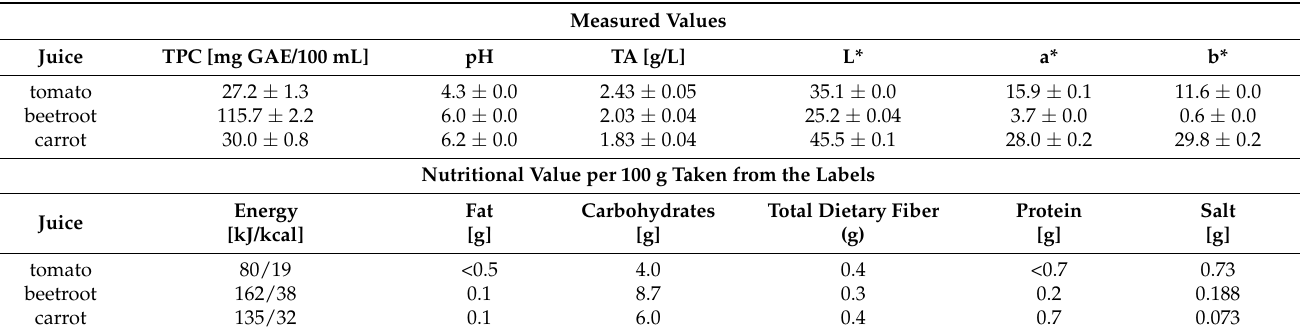
Table 1. Characteristics of vegetable juices used in the